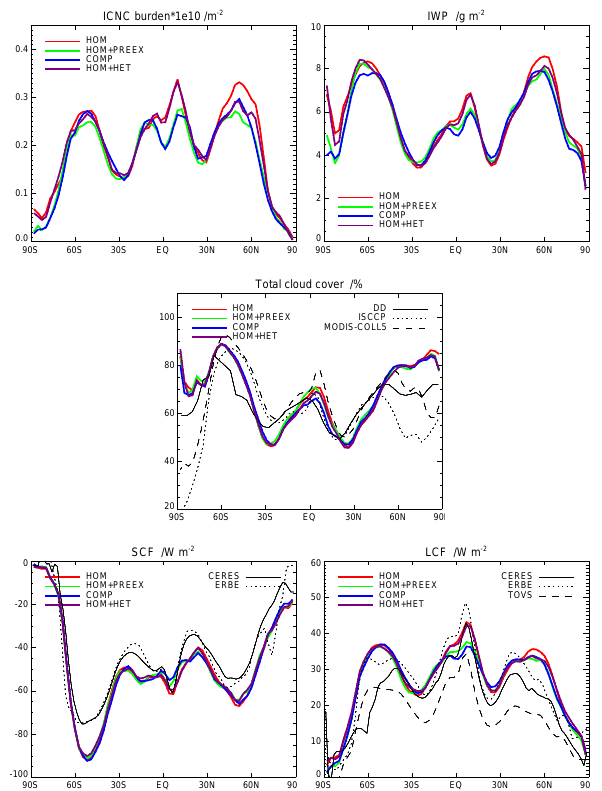
Fig. 4. Annual and zonal means of ICNC burden, IWP, TCC, SCF and LCF for the different simulations HOM,